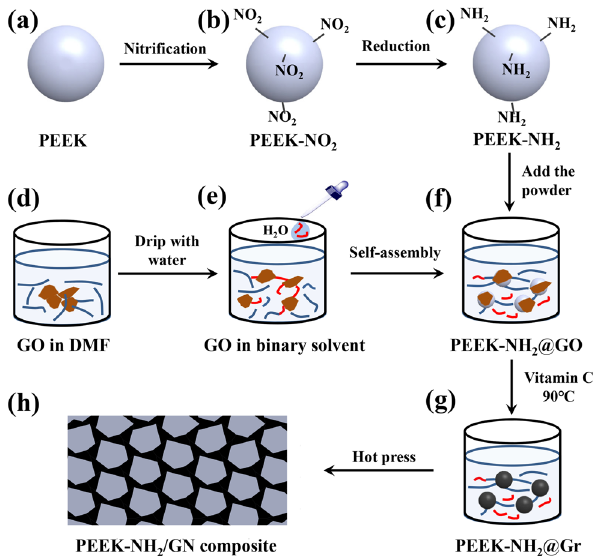
Scheme 1: Schematic illustration of the experiment route to prepare PEEK - NH 2 /GN composites. ( a – h ) Experimental steps described in the text of this article ( Section 3.1 )